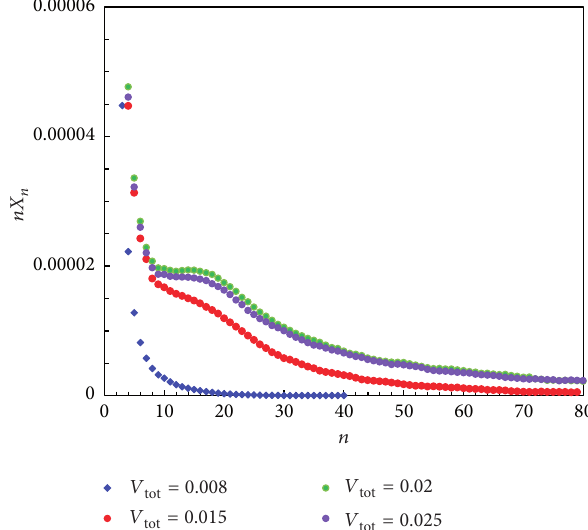
lattice 100 × 100 × 100